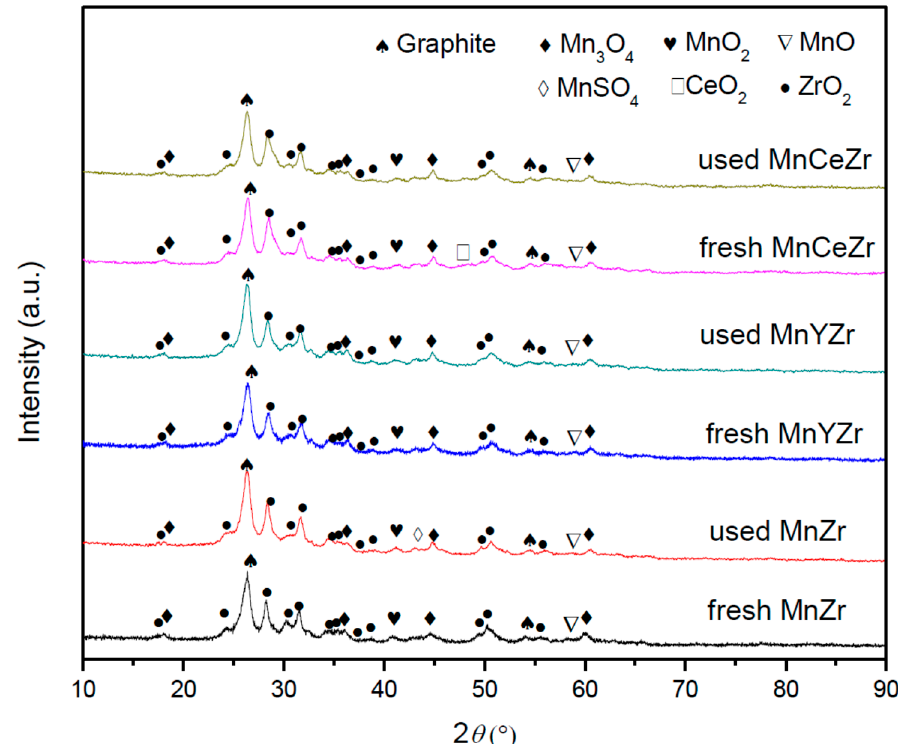
Figure 3. XRD patterns of catalysts before and after the reaction in the presence of SO 2 .